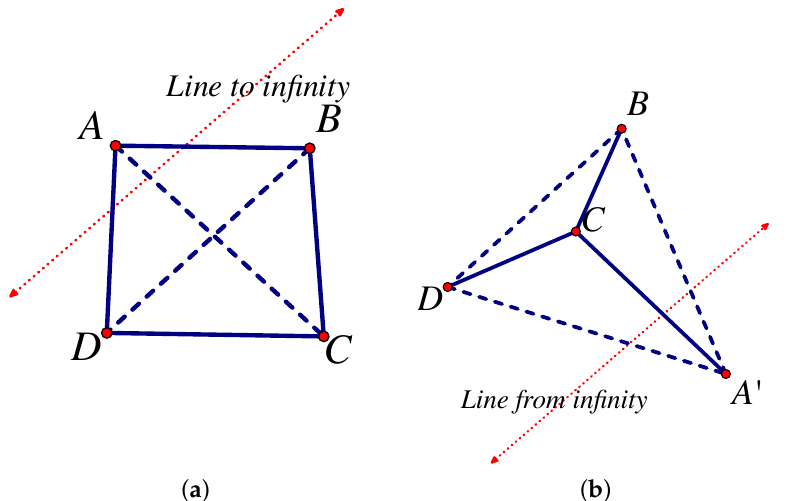
Figure 71. The projection of a plane tensegrity framework ( a ) changes the sign of all edges that crossed the line in ( a ) which is projected to infinity in ( b ).